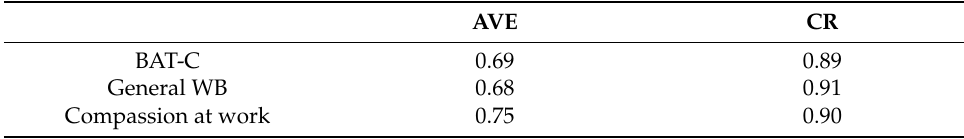
Table 2. Associations among Burnout, Compassion at work, and General well-being. BAT-C General WB Compassion at Work BAT-C - General WB − 0.543 ** - Compassion at work 0.394